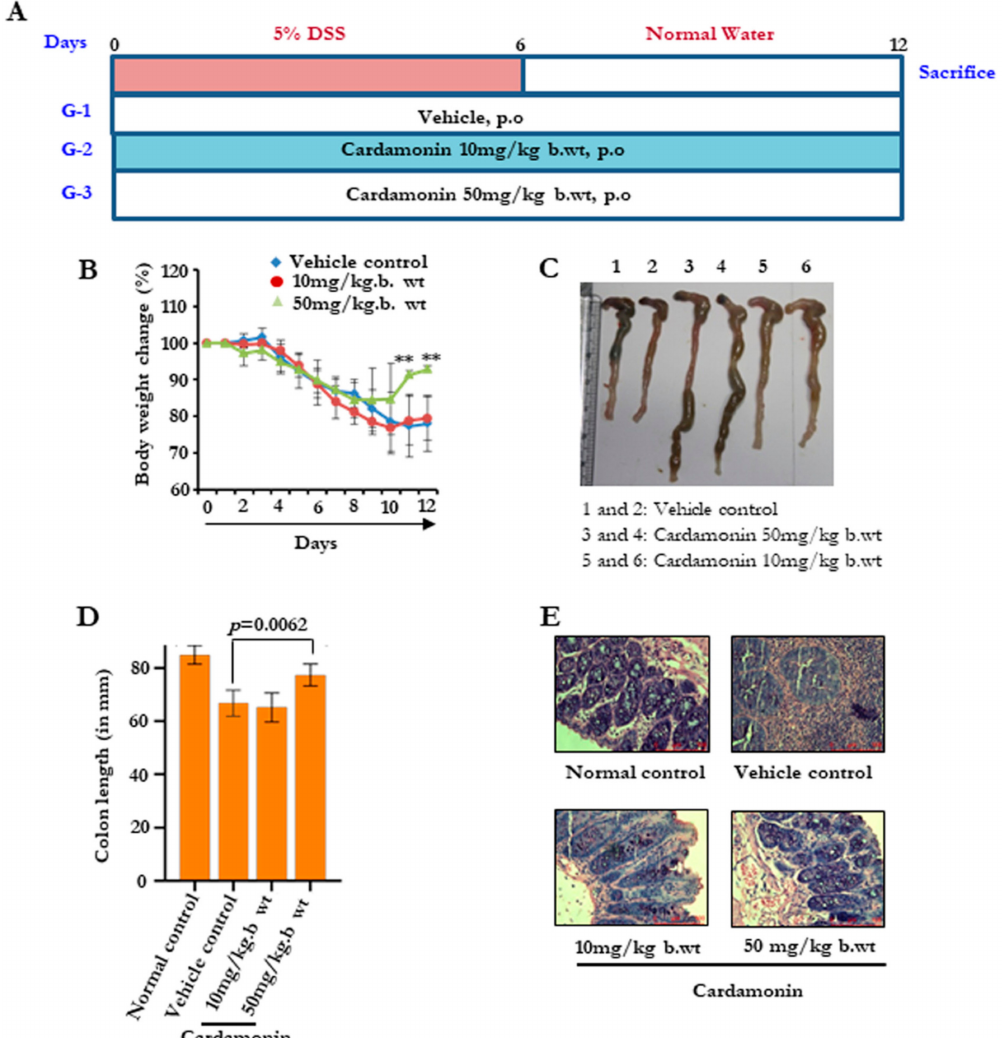
Figure 3. Cardamonin inhibits inflammatory signals and reduces DSS-induced colitis burden. ( A ) Schematic representation showing the time-bound drug treatments for establishing the DSS-induced colitis model. ( B ) The effect on body weight changes. Data are expressed as a percentage of body weight change. ( C , D ) The effect of cardamonin on colon length. ( C ) Representative pictures. 1 and 2, Vehicle control; 3 and 4, Cardamonin 50 mg/kg b.wt.; 5 and 6, Cardamonin 10 mg/kg b.wt. ( D ) Bar graph showing colon length in different groups on the last day of experiment. Statistical analysis was conducted using a t -test. ( E ) Representative H&E images of the colon from different groups. Scale bar = 100 µ